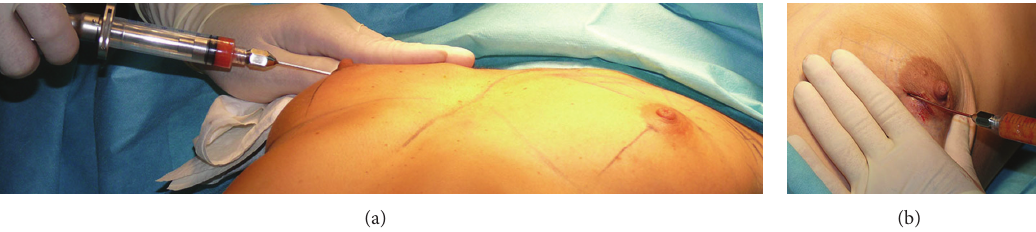
Figure 3: Purified fat and BMMNCs mixture reimplantation: (a) and (b) breast augmentation procedure (bicompartmental grafting).